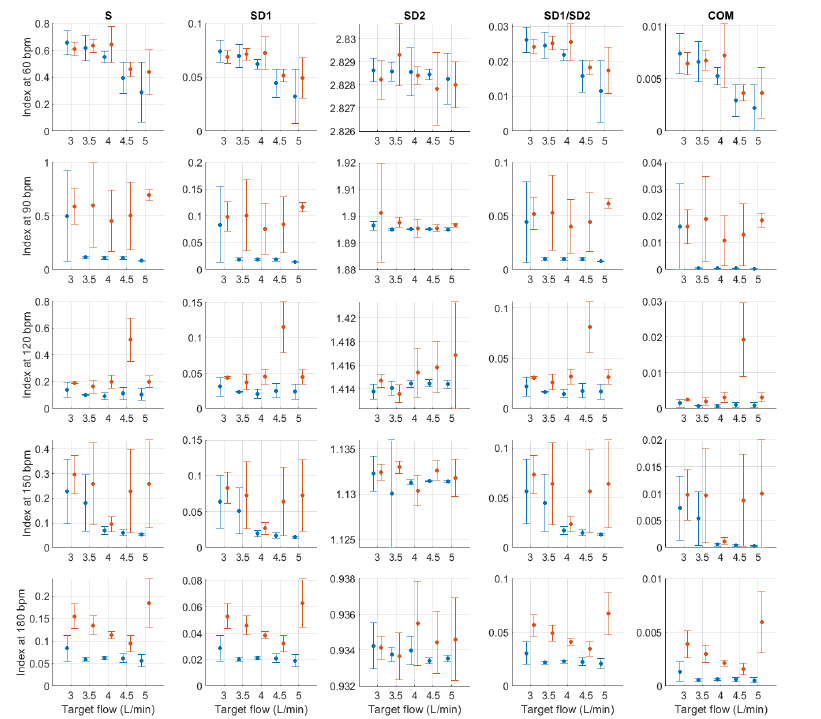
Figure A15. Mean and standard deviation of Poincaré plot indices extracted from pulse rate variability under different stroke rates (SR) and target flows (TF, TF above 2.5 L/min) conditions, and measured from the radial (blue) and deep palmar arch (orange) phantoms.